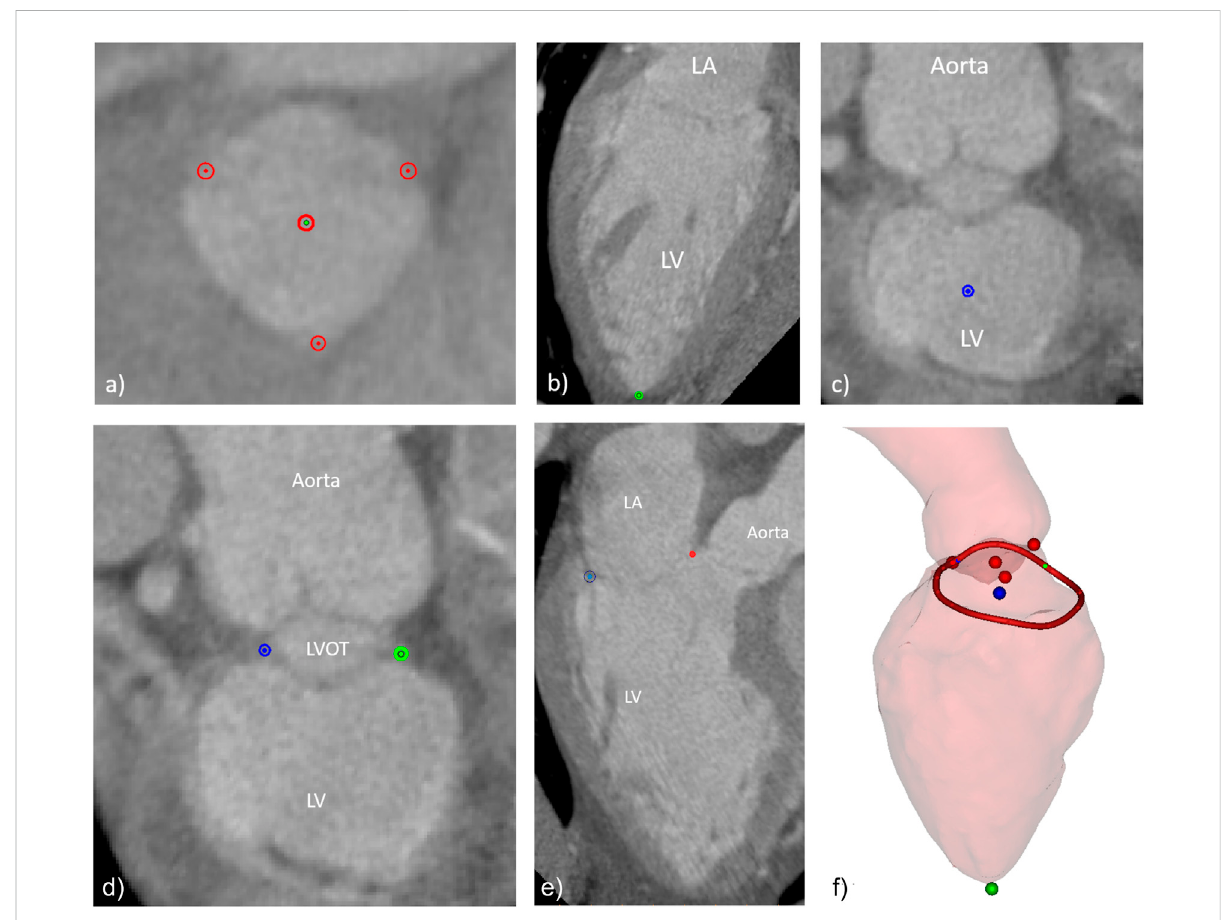
FIGURE 2 Manuallyindicatedlandmarks,including (A) aorticvalvecuspsandcenter, (B) leftventricularapex, (C) mitralvalvecenter, (D) fi broustrigones, (E) mitralannuluspointsinoneofthelongaxisplanesaroundthemitralvalvecenter,and (F) overviewof fi nalsetoflandmarksandthe3Dsurfacesofthe LV and the aortic root (the LA surface was excluded for